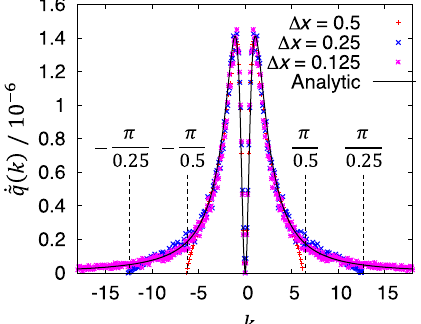
_ ˜ q FIG. 7. The small-temperature spectrum of heat rate , defined R _ Q − 2 V _ n 2 _ ˜ q by ¼ T ð k Þ dk þ O ð T 2 Þ , is measured numerically for different values of lattice spacing Δ x which controls the upper _ ˜ q cutoff π = Δ x of the spectrum. In practice, we express in terms of correlations of the density and polarization fields by taking the Fourier transform of the integrand in Eq. (C14). Below the cutoff, we observe a good agreement with our analytical predictions shown in solid lines, as given in Eq. (C18). Simulation details are in Appendix D, the same parameter values as in Fig.